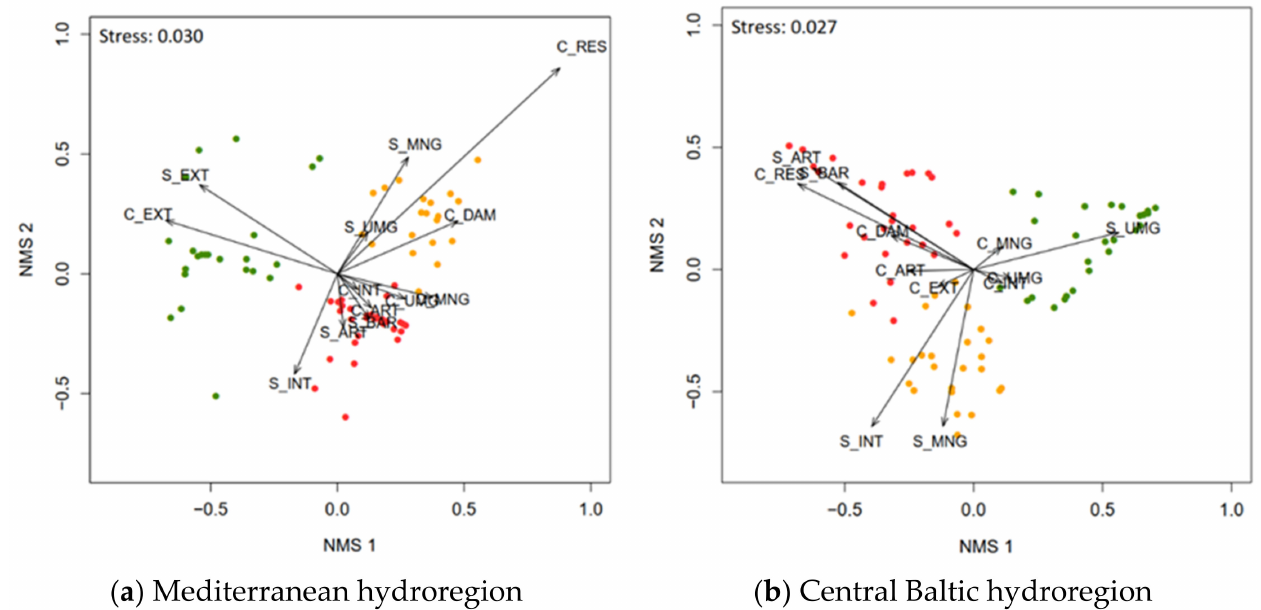
Figure 2. Non-metric Multidimensional Scaling (NMDS) biplot showing the distances among variables. Disturbance groups with sampling units organized in clusters (green = Least Disturbed; orange = Moderately Disturbed; red = Highly Disturbed) for the ( a ) Mediterranean and ( b ) Central Baltic